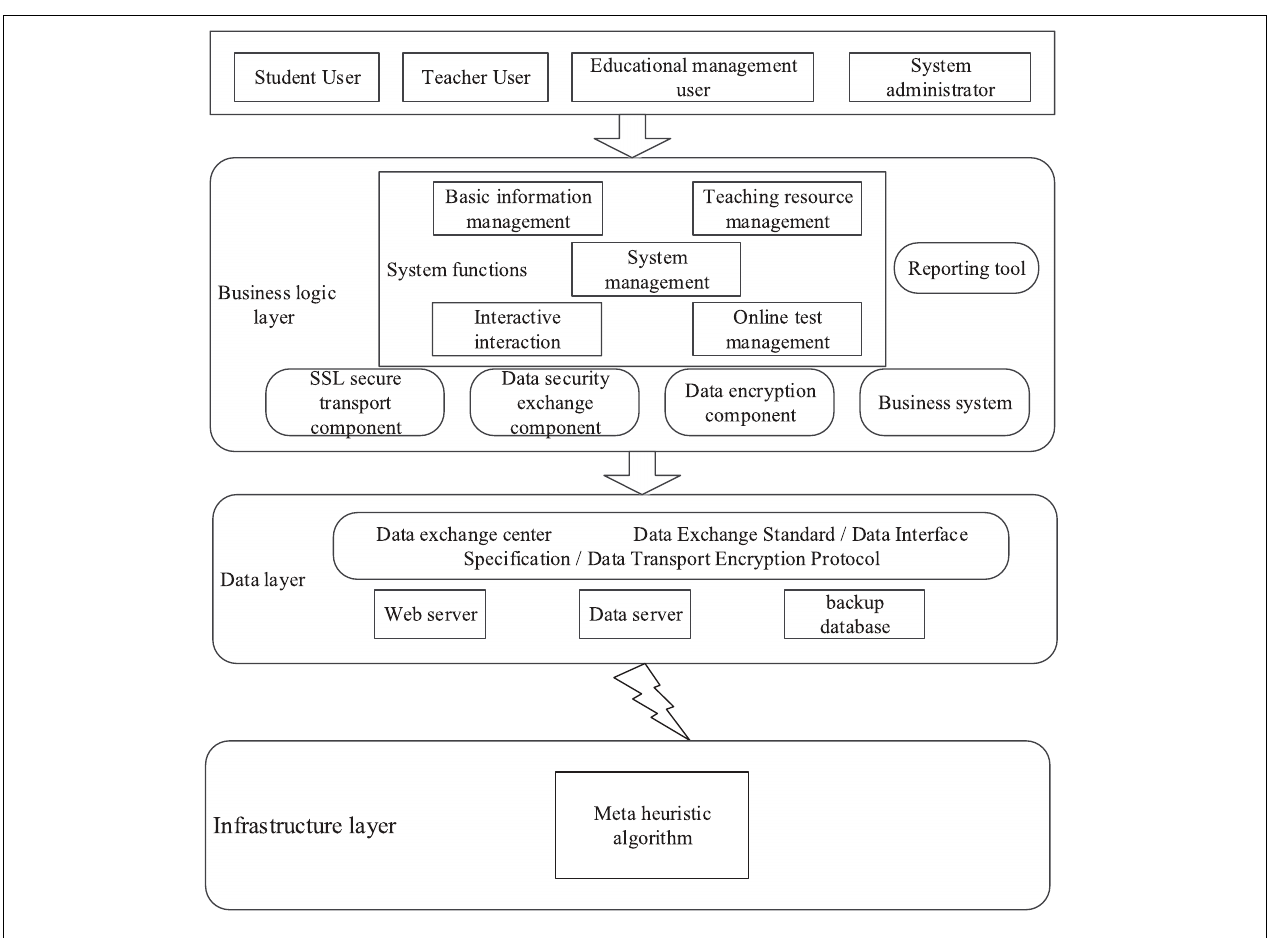
FIGURE 5 | System